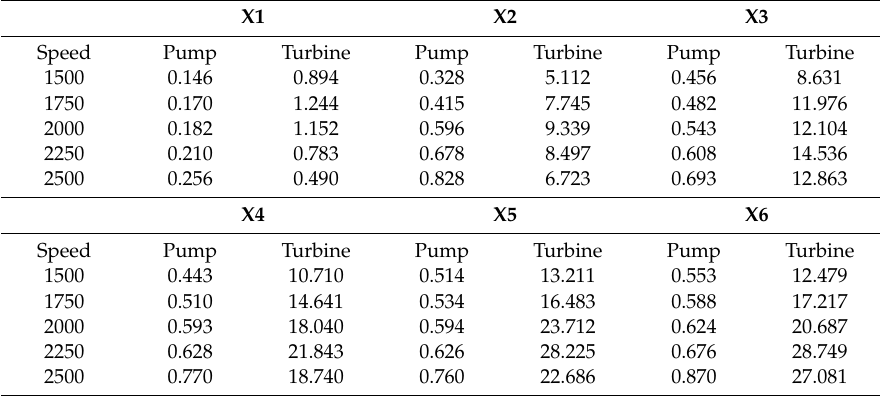
Table 3. ORC system speed variation simulations.